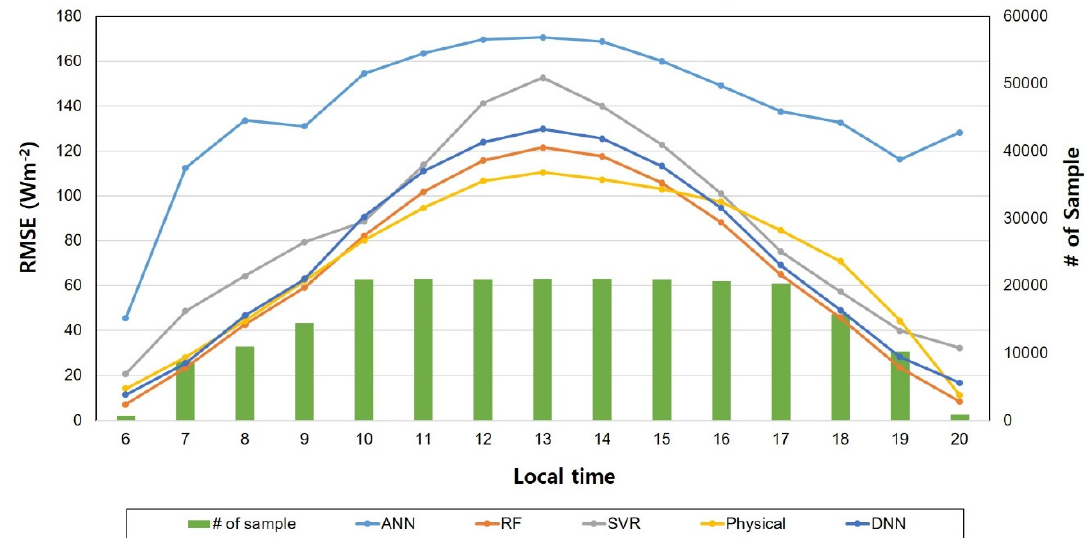
Figure 4. Temporal varations in root mean square error (RMSE) and sample number for each model by local time.